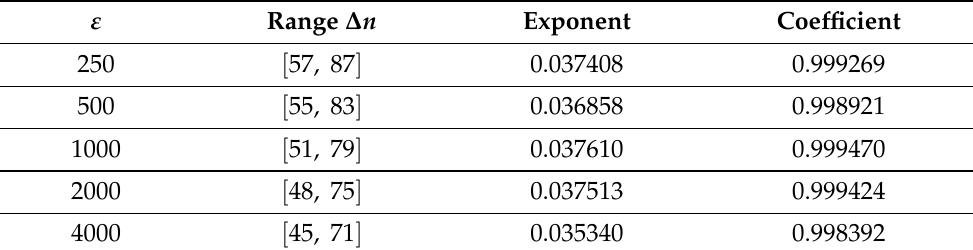
Table 11. Maximal Lyapunov exponents for coop3